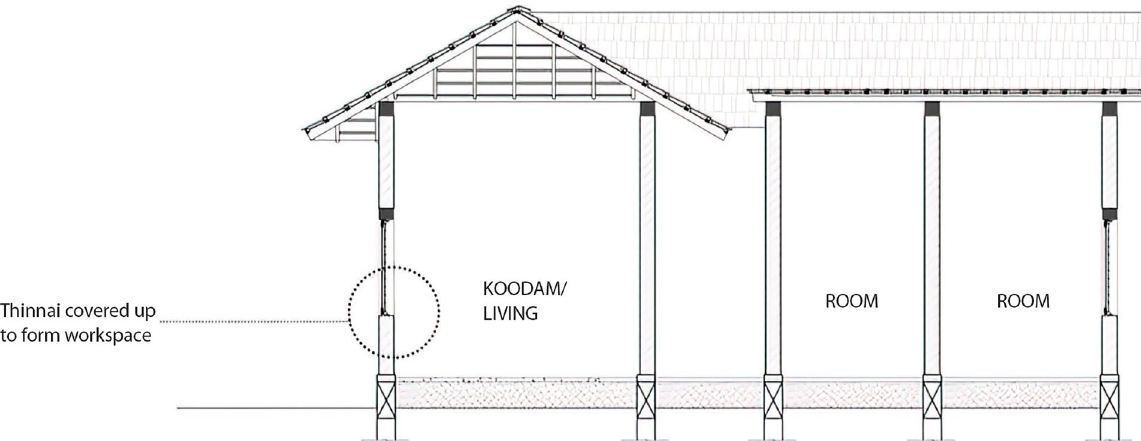
Fig. 17 Section of single-family dwelling (Source: the author)